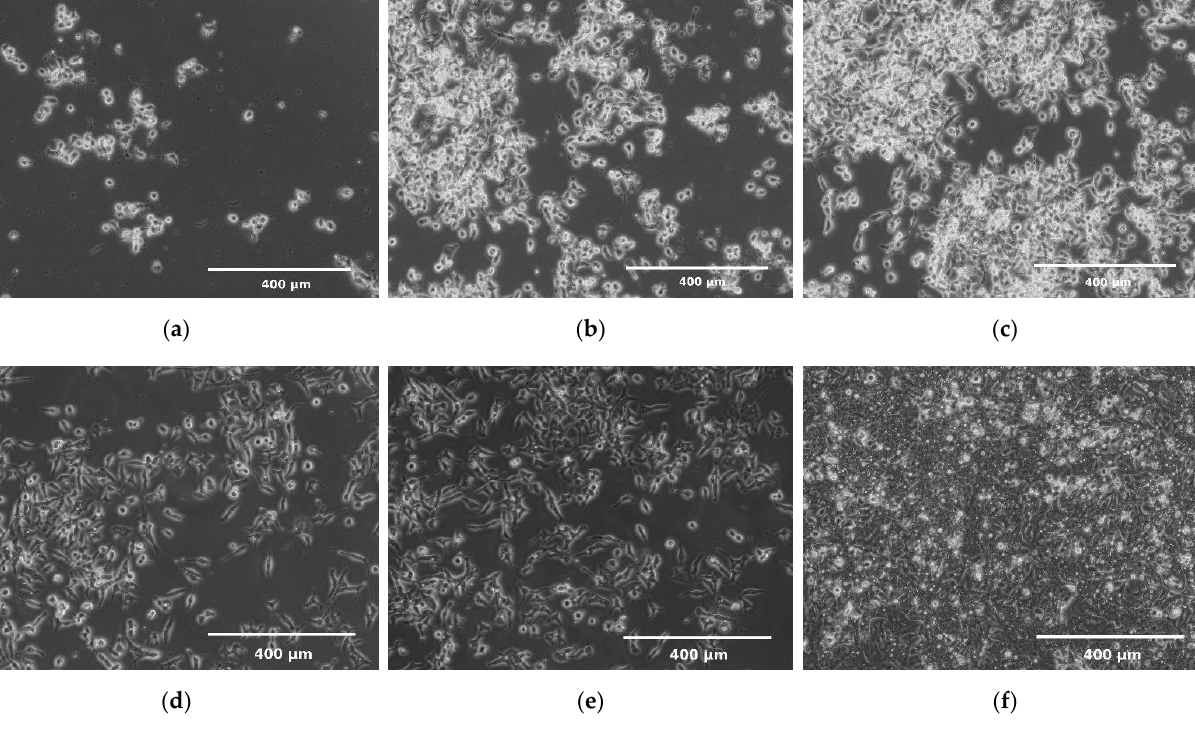
Figure 5. LoVo cells cultivation in conditions of a 5% CO 2 and at 37 °C: ( a ) after 24 h in 96-well plate; ( b ) after 72 h in 96-well plate; ( c ) after 7 days in 96-well plate; ( d ) after 24 h in a microchip; ( e ) 72 h in a microchip; ( f ) after 7 days in a microchip.